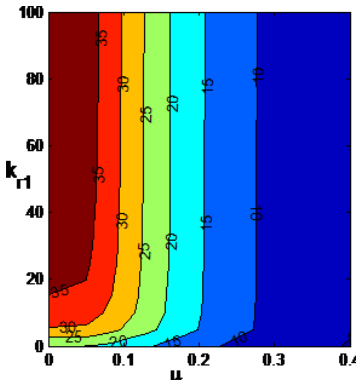
Figure 7. Contour plot of the buckling load q ( p = 0) with respect of k t and µ with k r0 = 10 8 (clamped at x = 0), k r1 = 0 (hinge at x = L ).